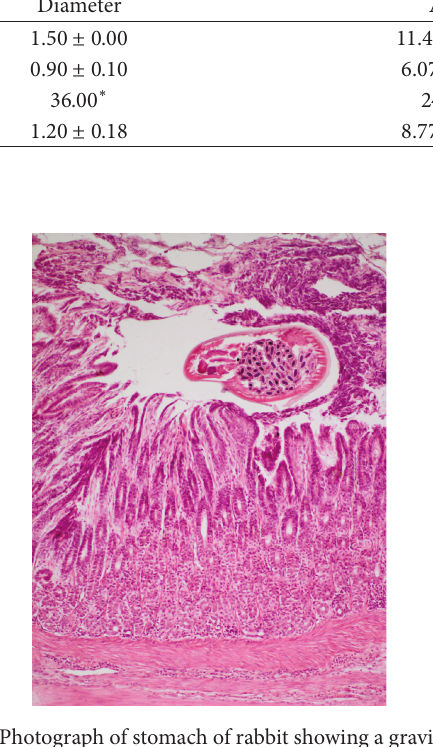
were analysed using SPSS 16.0 version by one-way analysis of variance and the means were compared by Tukey’s b and Duncan’s Multiple Range